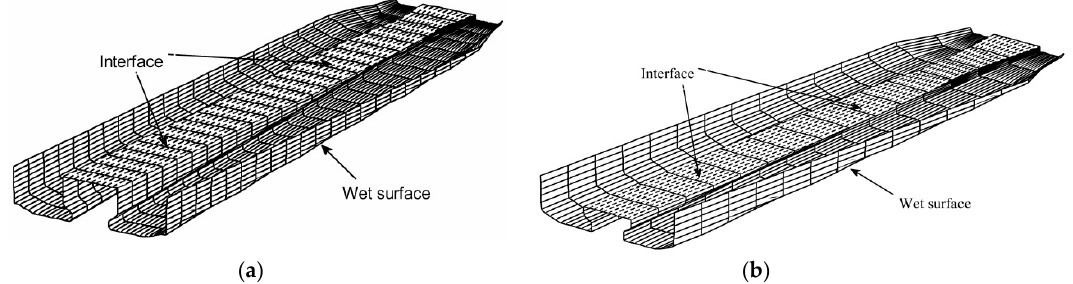
Figure 5. Strip panels of the PACSCAT for the single-domain and multi-domain 2.5D method. ( a ) The strip panels for the single-domain 2.5D method, in which the interface and outside free surface are at the same water level; ( b ) The strip panels for the multi-domain 2.5D method, in which the interface is lower than the outside free surface.